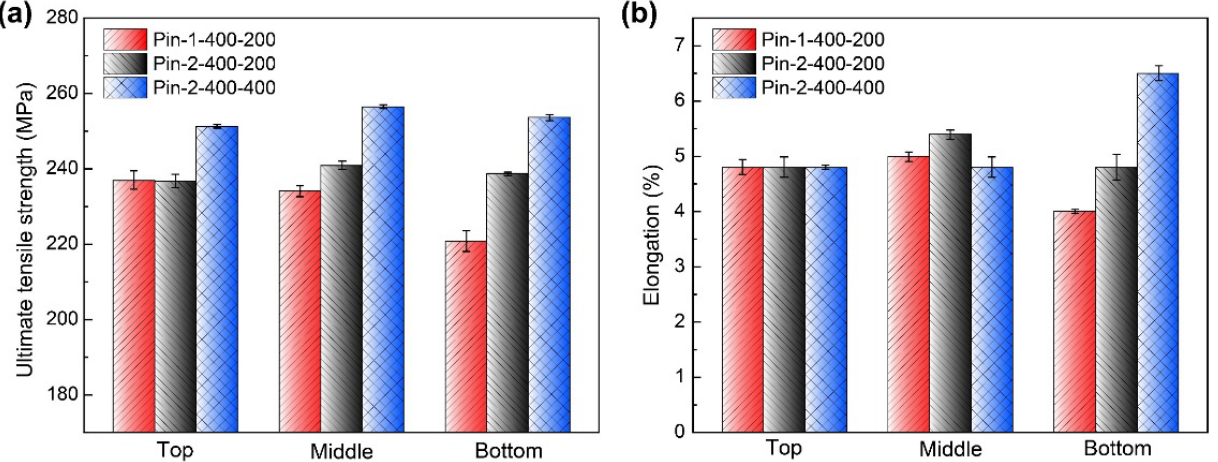
Figure 15. Tensile properties of different layers ( a ) ultimate tensile strength and ( b ) elongation. Figures 16 and 17 display the tensile fracture features of the joints by the two pins at different welding speeds, respectively. For the joint by Pin-1, the bottom fracture location is near the edge of the WNZ at a welding speed of 100 mm/min. When the welding speed is 200 mm/min, the bottom fracture path is at the WNZ with significant angular deflection and a height of 2.4 mm. The cavities in the bottom WNZ act as crack sources, promoting the initiation and propagation of cracks. The fracture zone located in the WNZ gradually increases with increasing welding speeds. It reaches a height of 4.3 mm at a welding speed of 400 mm/min, nearly half the thickness of the joint. These results are consistent with the defect morphology shown in Figure 7. All the joints by Pin-1 are fractured on the AS side due to the small tip pin leading to poor material flow at the bottom joint, which reduces the metallurgical bonding at the edge of the WNZ. For the joint by Pin-2, all specimens fracture along a path showing a 45 ◦ angle to the tensile axis, a typical feature of shear fracture patterns. The bottom fracture location approaches from HAZ to WNZ with increasing welding speeds. It is completely inside the HAZ at a welding speed of 100 mm/min, and occurs at the outer edge of the WNZ at a welding speed of 200 mm/min and at the inner edge of the WNZ when the welding speed is 500 mm/min. The heat generation at the bottom gradually decreases with increasing welding speeds, suppressing thermal damage in the HAZ. The metallurgical bonding of the boundary between HAZ and WNZ deteriorates with decreasing heat input, thus changing the fracture location from HAZ to